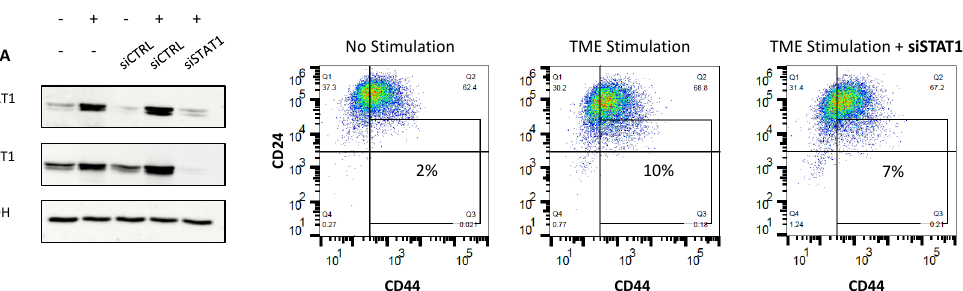
A2. siSTAT1: CSC enrichmentA1. siSTAT1: Validation